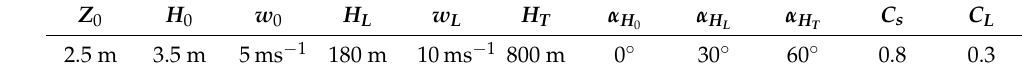
Table 2. Parameters of low-level jet model.